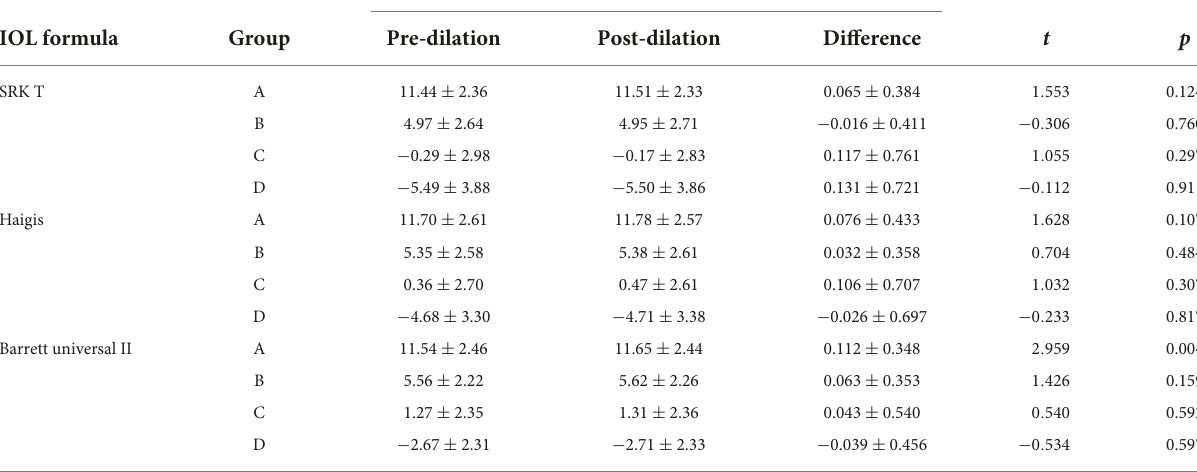
TABLE 2 The mean intraocular lens (IOL) power (D) calculated by IOLMaster 700 before and after pupil